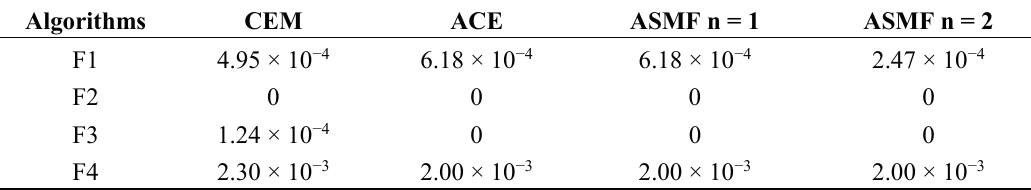
Figure 16. ROC curves corresponding to the detection results reported in Figure 15. ( a ) F1, ( b ) F2, ( c ) F3, and ( d ) F4. Table 3. FARs under 100%